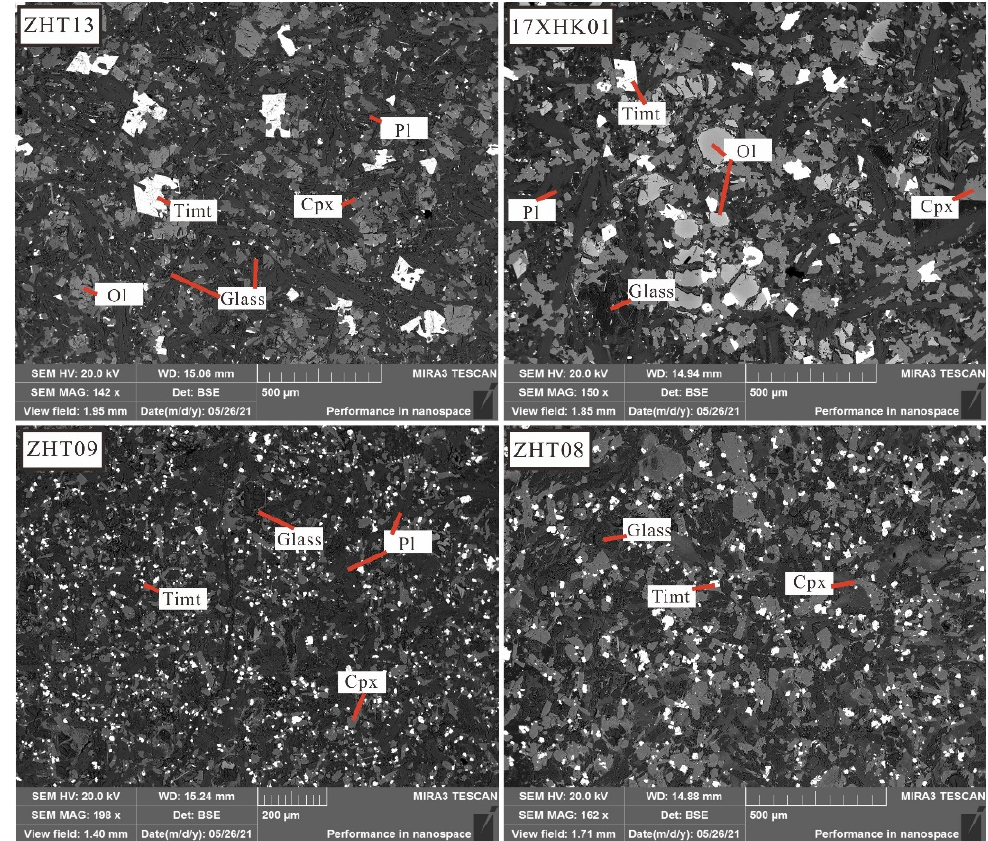
Figure 3. Representative BSE photographs of Hannuoba alkaline basalt with different crystal sizes. Samples with coarse-grained phenocrysts, such as 17XHK01 and ZHT13, have relatively coarse-grained groundmass crystals, while samples without phenocrysts, such as ZHT09 and ZHT08, have relatively fine-grained groundmass crystals. The crystal sizes significantly differ, implying different cooling rates during melting solidification. Pl: Plagioclase, Cpx: Clinopyroxene, Timt: Titanomagnetite, Ol: Olivine. The mineral symbols are referred to as Warr [84].